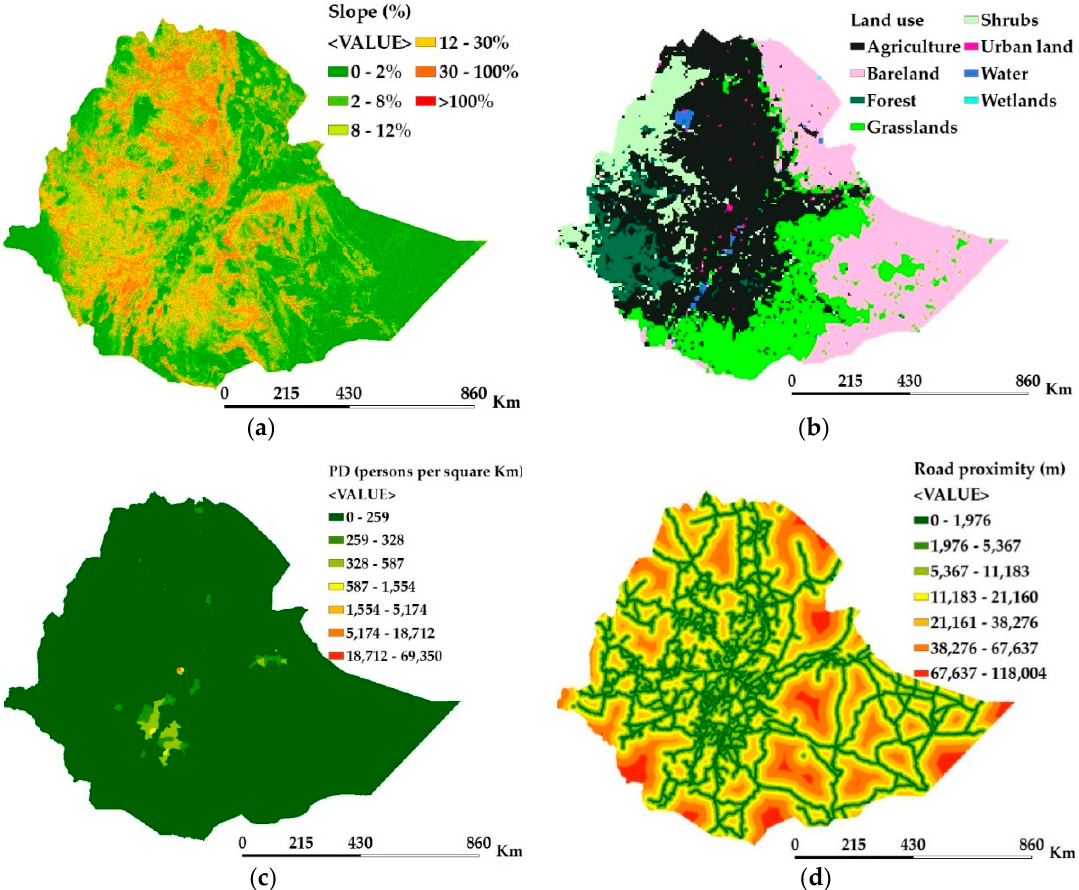
Figure 3. Irrigation suitability factors map: ( a ) Topography in terms of landscape slope, ( b ) land use, ( c ) population density (PD), and ( d ) distance to road networks.